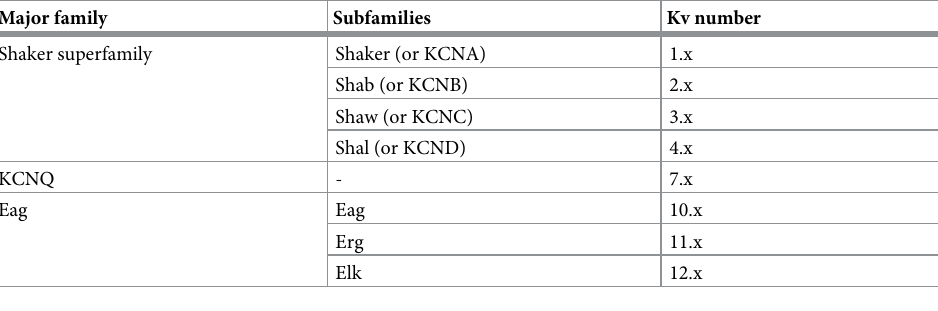
Table 1. Three major Kv channel